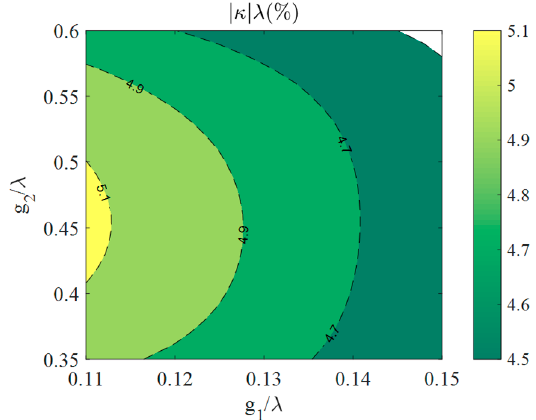
Figure A2. Contour of | κλ | as a function of g 1 and g 2 . ϕ k and ϕ α are shown in Figure A3a,b, respectively.